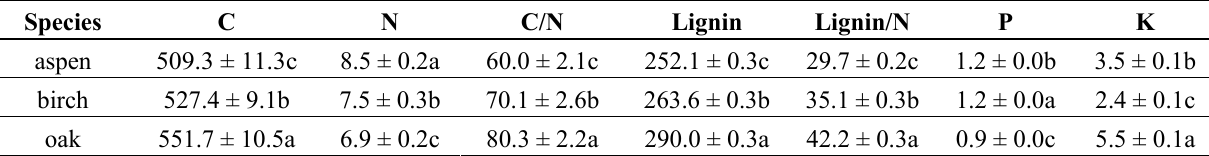
Table 1. Initial chemical properties of the three leaf litter species, i.e. , aspen ( Populus davidiana Dode), birch ( Betula platyphylla Sukaczev) and oak ( Quercus mongolica Fischer ex Ledebour)